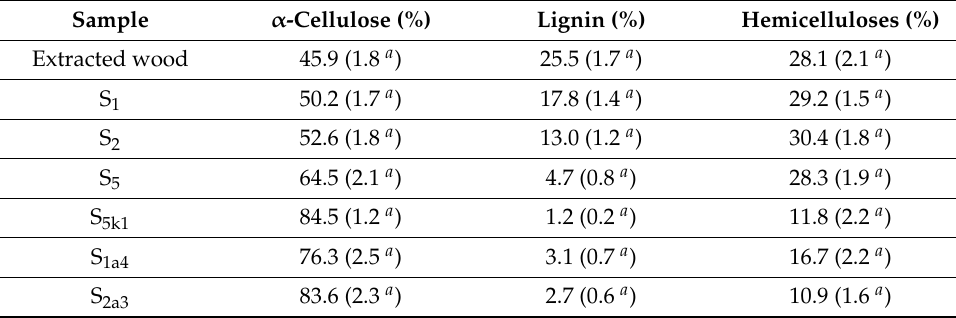
Table 1. Chemical composition of the samples at different